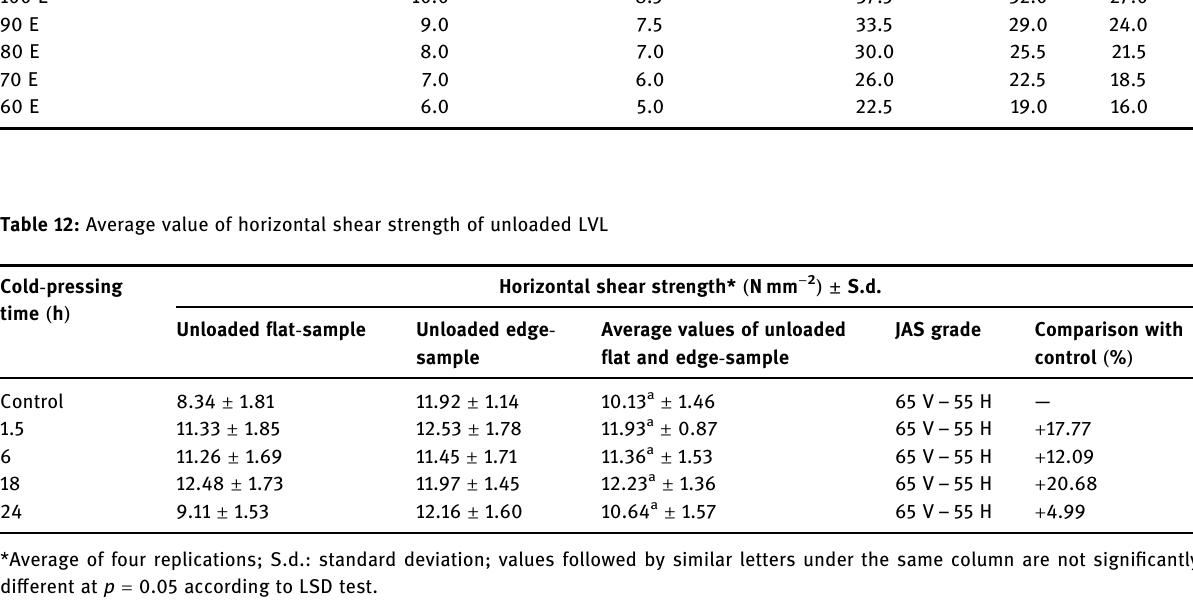
Table 13: Average value of horizontal shear strength of loaded LVL